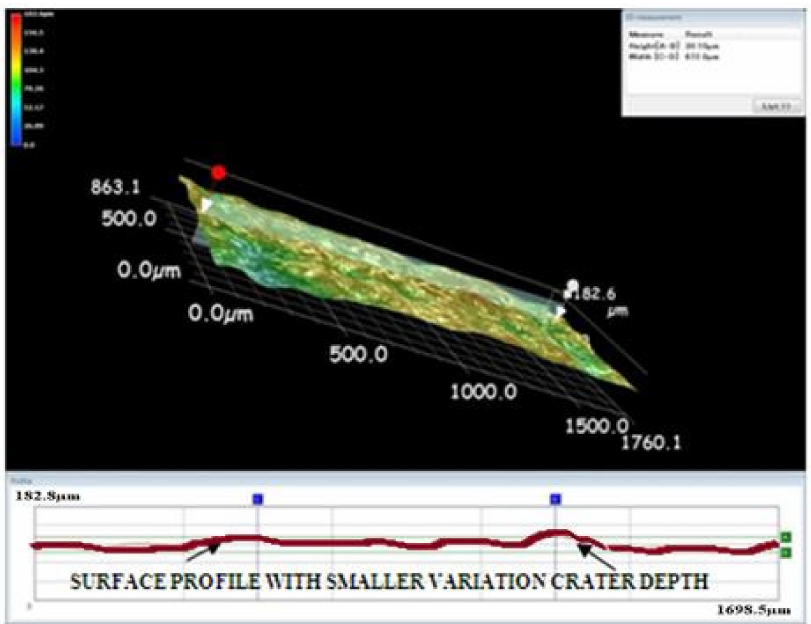
Figure 11. Three-dimensional view of the machined surface using the tungsten carbide tool electrode.